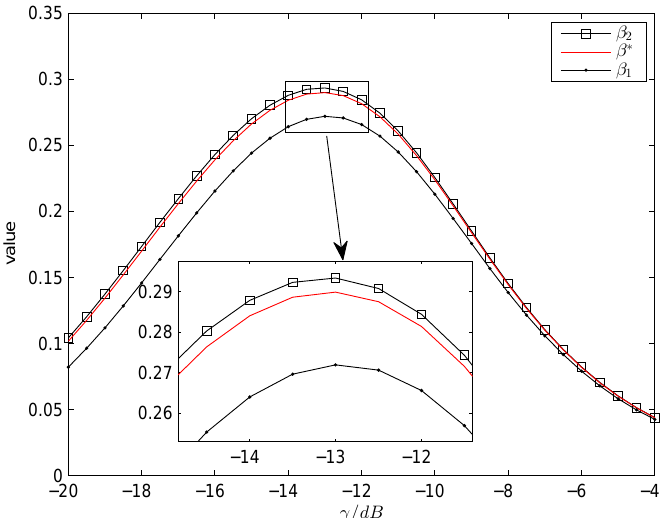
Figure 4. The lower bound β 1 , the upper bound β 2 and the optimal β ∗ versus γ